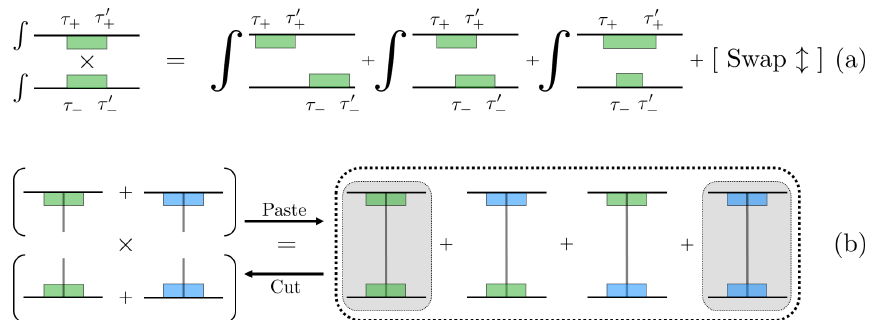
Figure 7: Cutting and pasting rules for Keldysh diagrams to test and guarantee CP, respectively. (a) Time ordering : Factorization into separate one-branch time-ordered expressions (left) –dictated by the operator-sum form– requires both two-branch re- ducible and irreducible Keldysh diagrams to be summed (right). (b) Cutting : Given a selection of diagrams on the right hand side, one can verify it has an operator-sum form by first cutting horizontally and summing up the halves. Pasting : Subsequently pasting the halves back together should recover the selection. Leaving out, for ex- ample, the center two diagrams on the right hand side, this test of ‘completing the square’ will fail. When directly selecting half -diagrams on the left hand side, every possible approximation (select only green, only blue or select both) by construction produces one of the three groups indicated by dashed lines and shading on the right, each of which is a CP